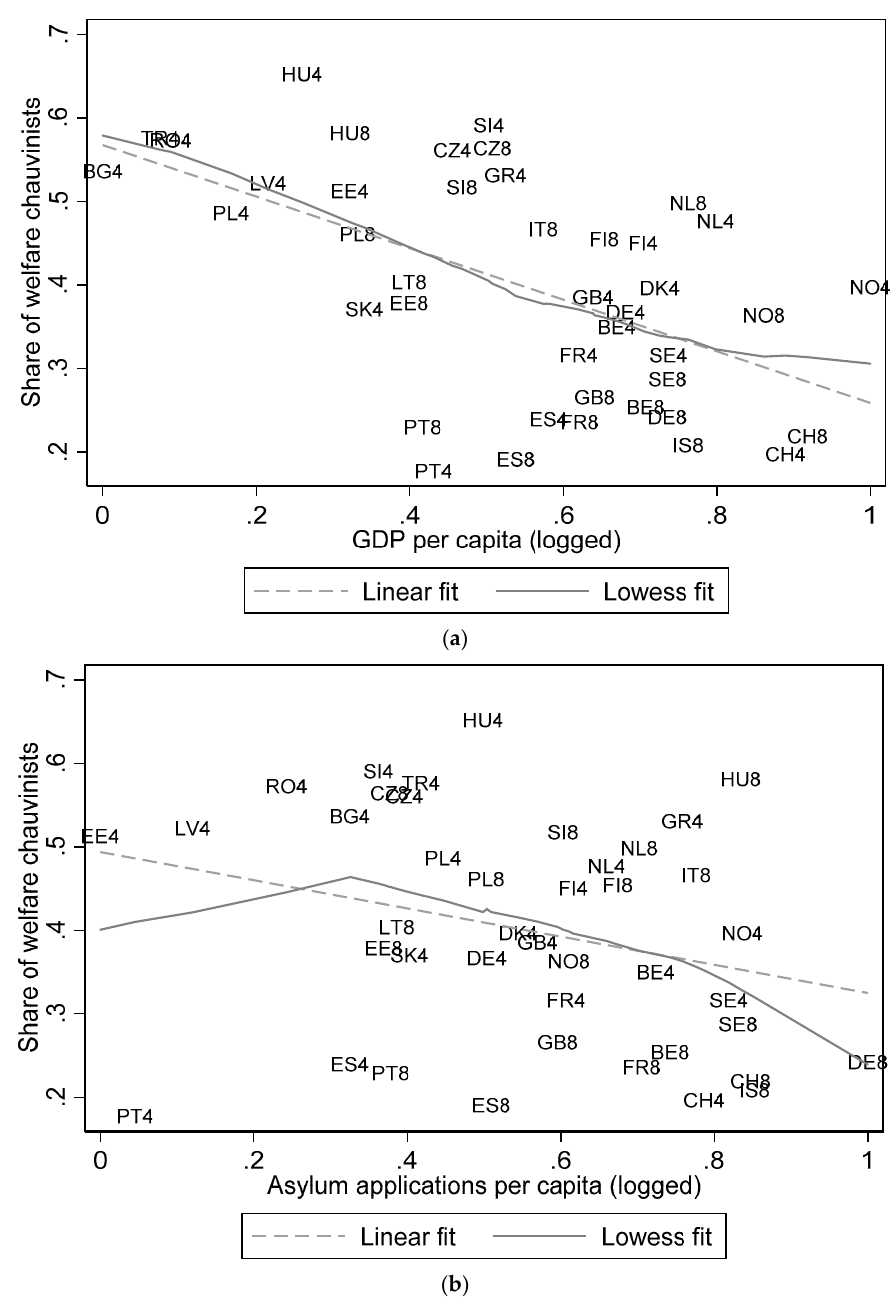
Figure 1. Macro-Level Scatterplots of Welfare Chauvinism. ( a ) Relationship between GDP per capita and the weighted share of welfare chauvinists; ( b ) relationship between asylum seeker ratio and the weighted share of welfare chauvinists.